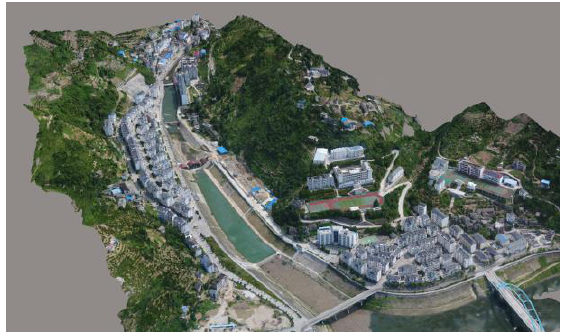
Figure 5. 3D textured mesh surface of the study area